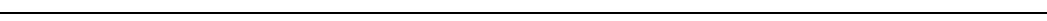
Fig. 5 Biallelic inactivation of TP53 and RB1 and whole-genome duplication (WGD) in adult LMS. a Combined analysis of genetic lesions and allele-speci fi c copy number showing frequent biallelic inactivation of TP53 and RB1 . In the top panels, samples are plotted from left to right based on their copy number composition, and genetic lesions speci fi c for the A and B alleles as well as the presence or absence of WGD are annotated according to the color code. Asterisks indicate cases with either loss of CDKN2A expression in combination with CCND1 overexpression or MAX mutation. In the bottom panels, allele- speci fi c integral copy numbers are plotted. Cases with retention of a single allele are assigned to the loss-of-heterozygosity (LOH) group, cases with one or more alleles derived from the same parental allele are assigned to the copy number-neutral (CNN) or higher-ploidy LOH groups, and cases with different combinations of maternal and paternal alleles are assigned to the normal or biallelic alteration group, respectively. TS transcriptome sequencing. b Scatter plots showing expression of CDKN2A and CCND1 in cases with wild-type and aberrant RB1 (left) and expression of CDK4 and CCND2 in cases with wild-type and mutant MAX (right). FPKM fragments per kilobase of transcript per million mapped reads. c Scatter plots showing congruency of TP53 and RB1 variant allele frequencies with tumor purity as detected by allele-speci fi c copy number analysis. d Allele-speci fi c copy-number pro fi les for a primary tumor/ metastasis pair showing absence of WGD in the primary tumor (top) and presence of WGD in the metastasis (bottom). Chromosomes are represented along the horizontal axis, copy numbers are indicated along the vertical axis. The purple line indicates the total allele-speci fi c copy number. The blue line indicates the minor allele-speci fi c copy number. e Genes involved in cell cycle regulation or PI3K-AKT-mTOR signaling recurrently affected by genetic alterations in LMS tumors. Blue and red boxes denote genes with inactivating and activating lesions, respectively. Percentage values indicate the